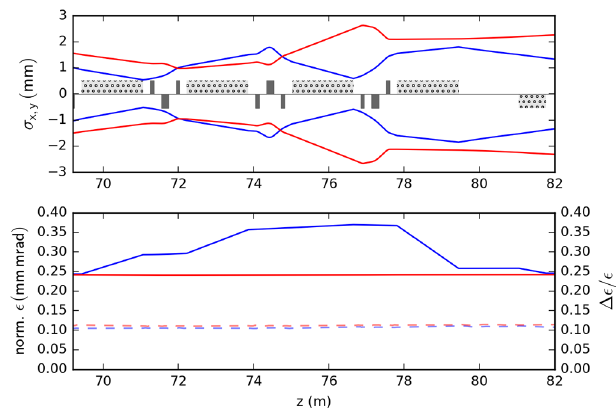
FIG. 15. rms beam envelope through the second arc with waterbag initial distribution and 40 mA bunch current.